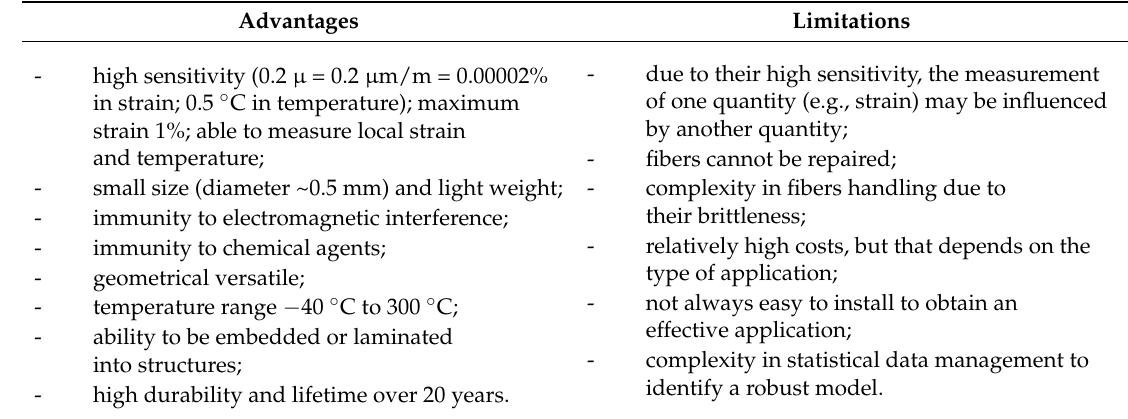
Table 2. A comparison between the main advantages and limitations of the FBG sensor application. Advantages Limitations